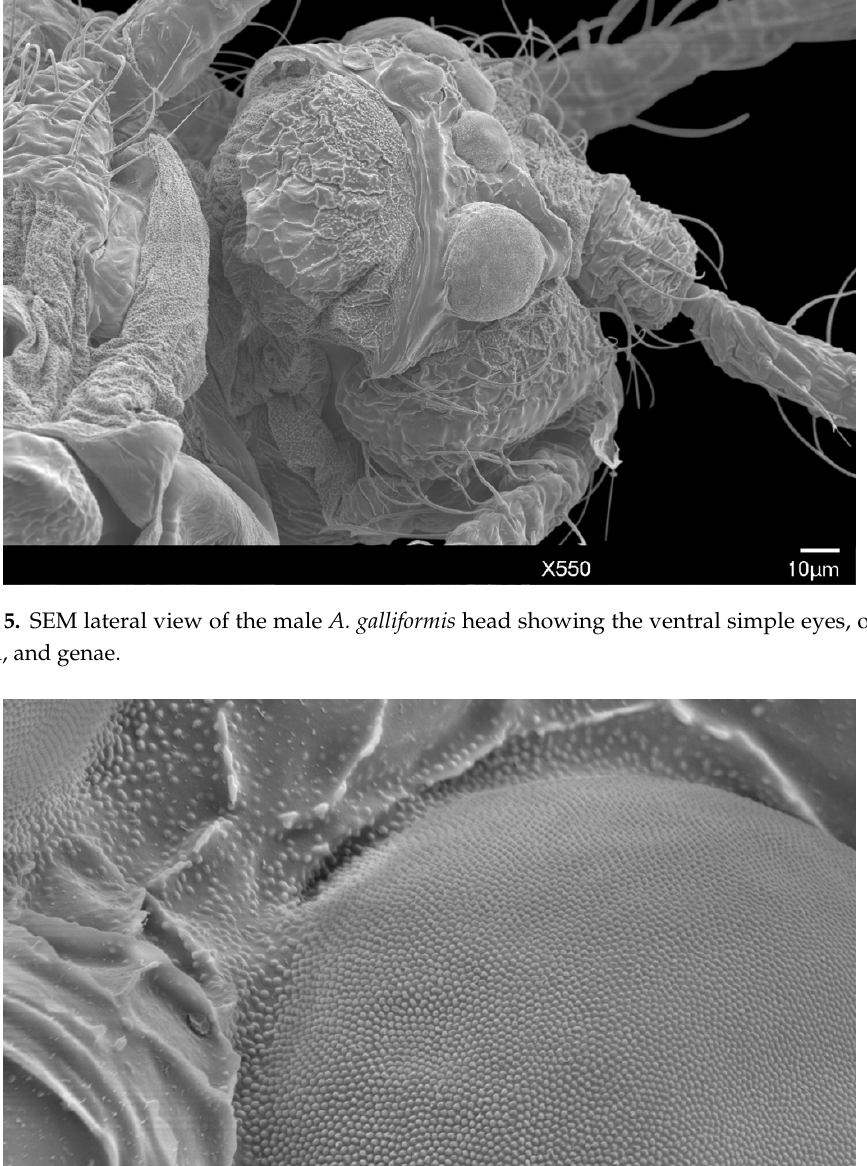
Figure 7. SEM of the male A. galliformis tarsus, tarsal digitules, ungual digitules, and claw. Wax excretions are present on the tarsus and proximal portion of the claw.